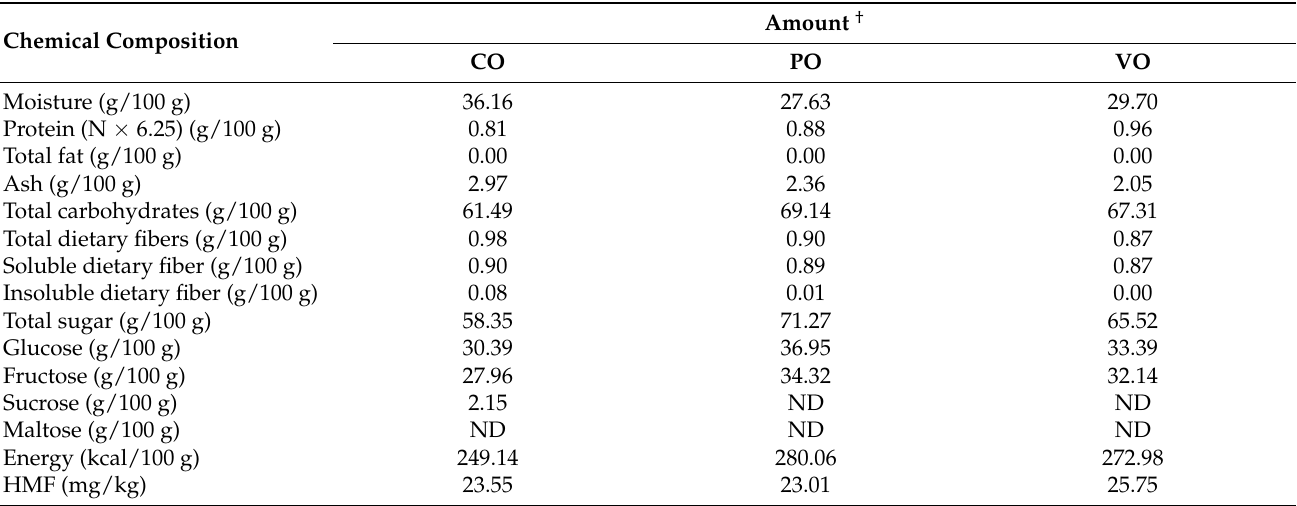
Table 4. Chemical composition of date syrups prepared using different extraction methods followed by evaporation using open heating.